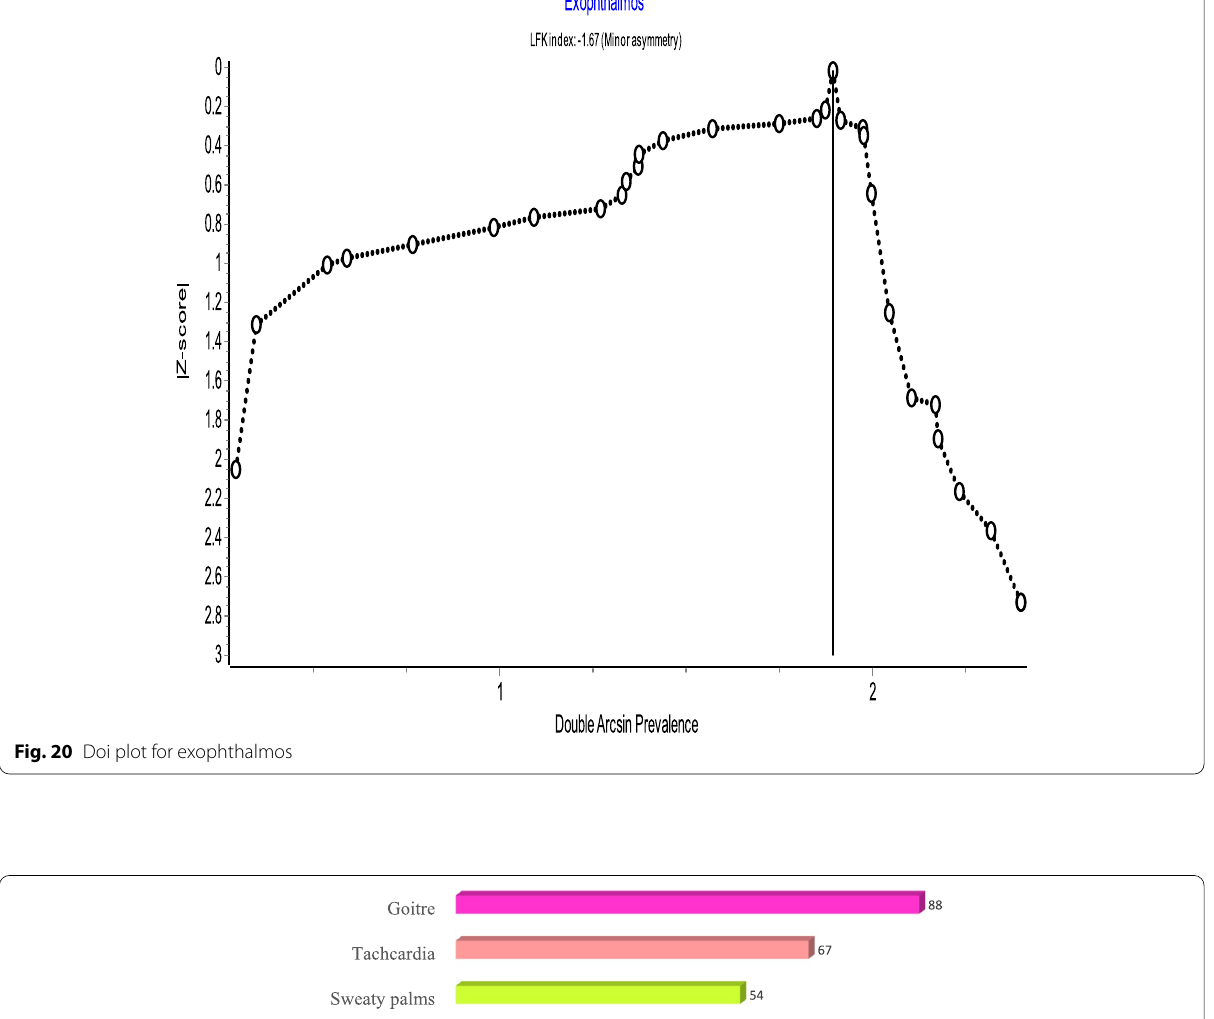
Fig. 20 Doi plot for exophthalmos